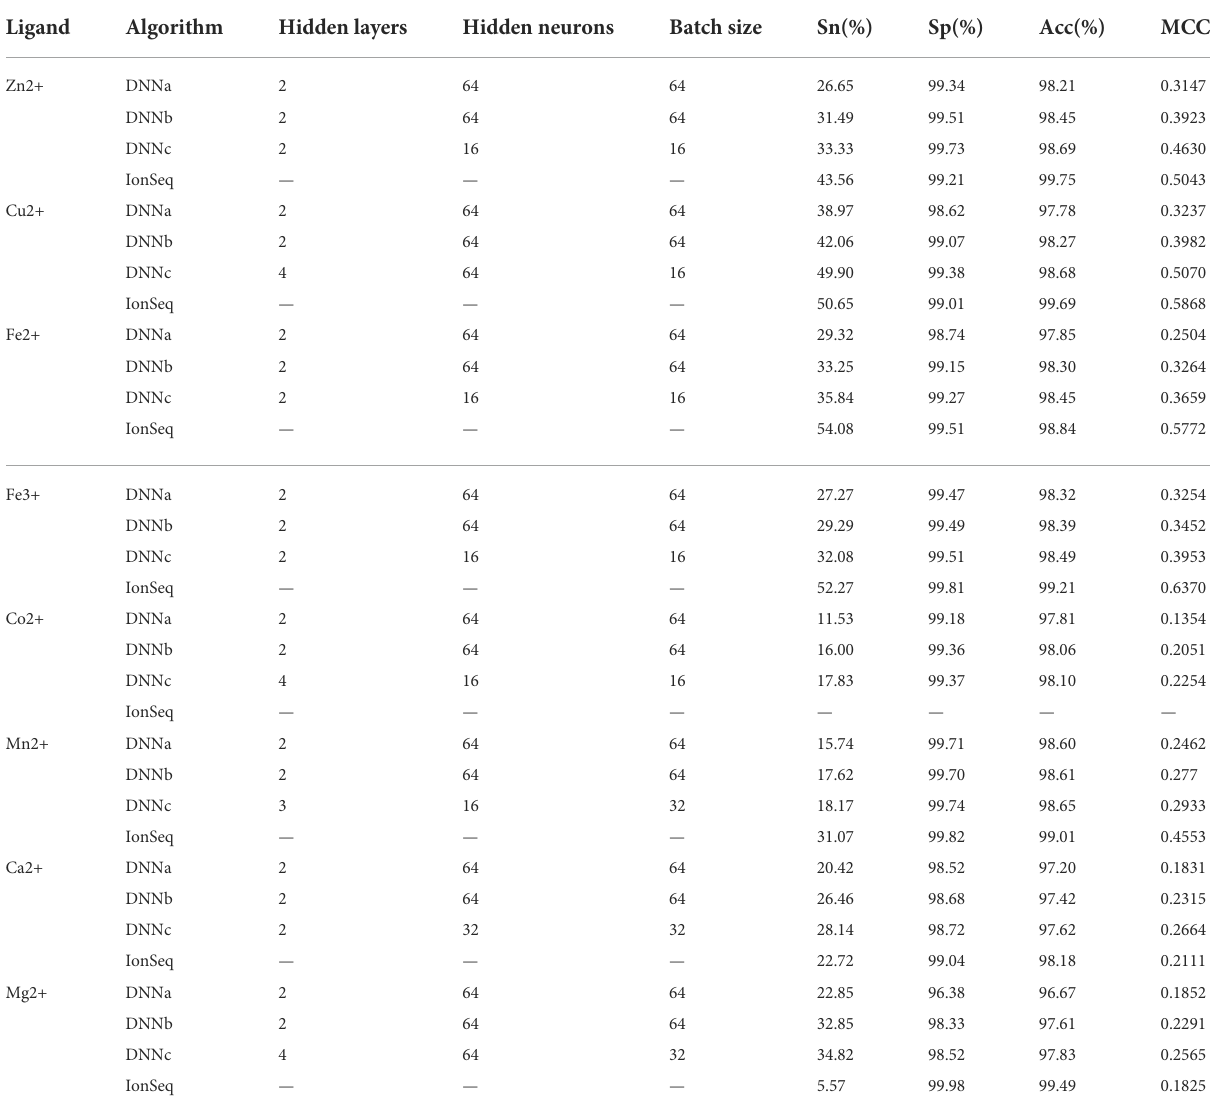
TABLE 2 Comparison of 5-fold cross-validation results.